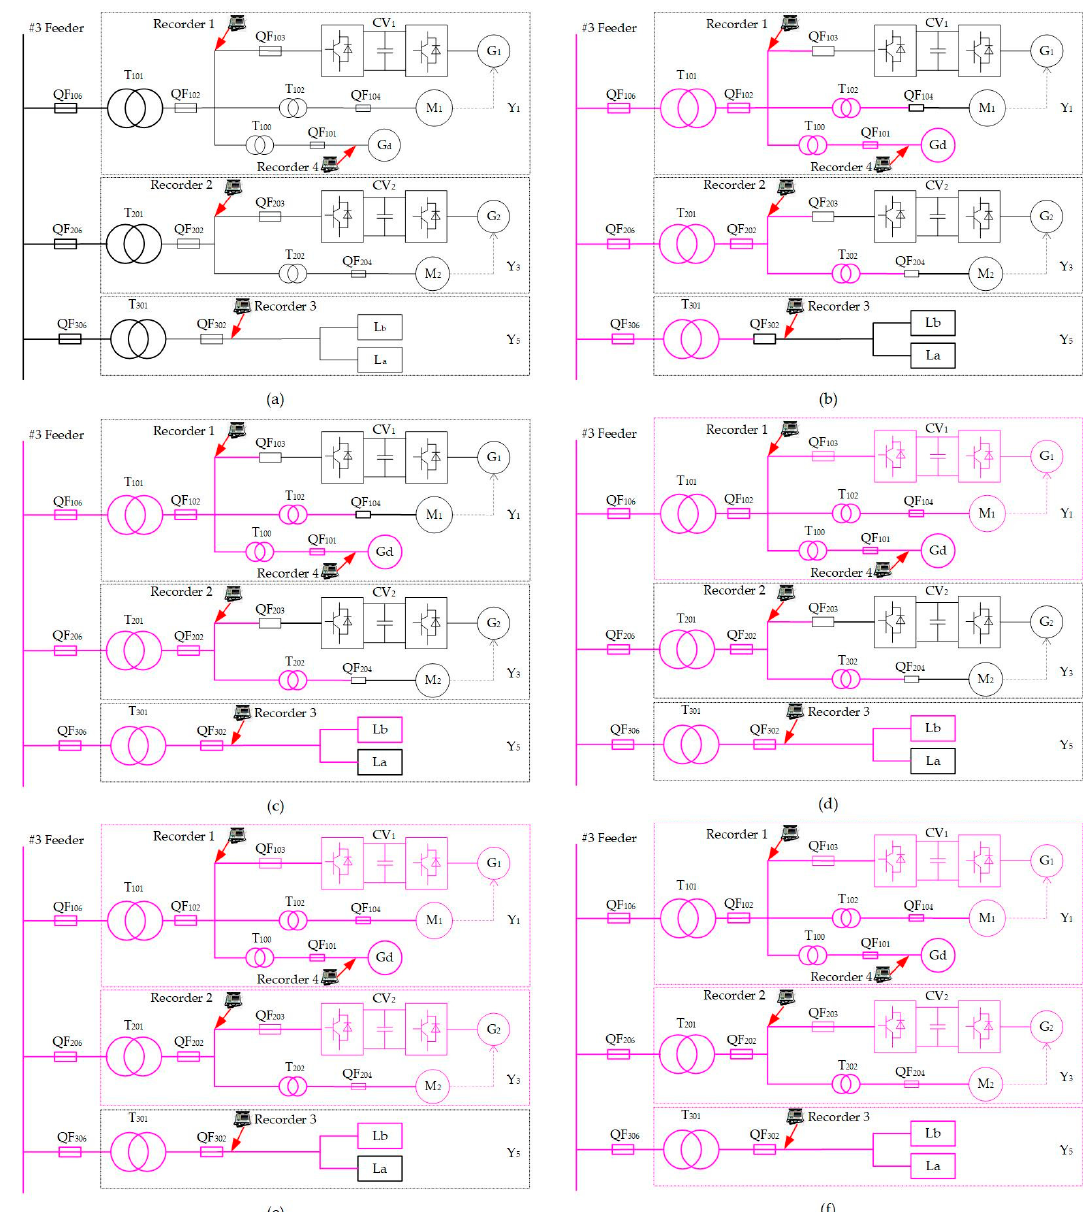
Figure 7. ( a ) equipment installation and system debugging, ( b ) charging for the primary equipment, ( c ) powering Lb, ( d ) self-tarting Y1, ( e ) self-tarting Y3, ( f ) black starting La